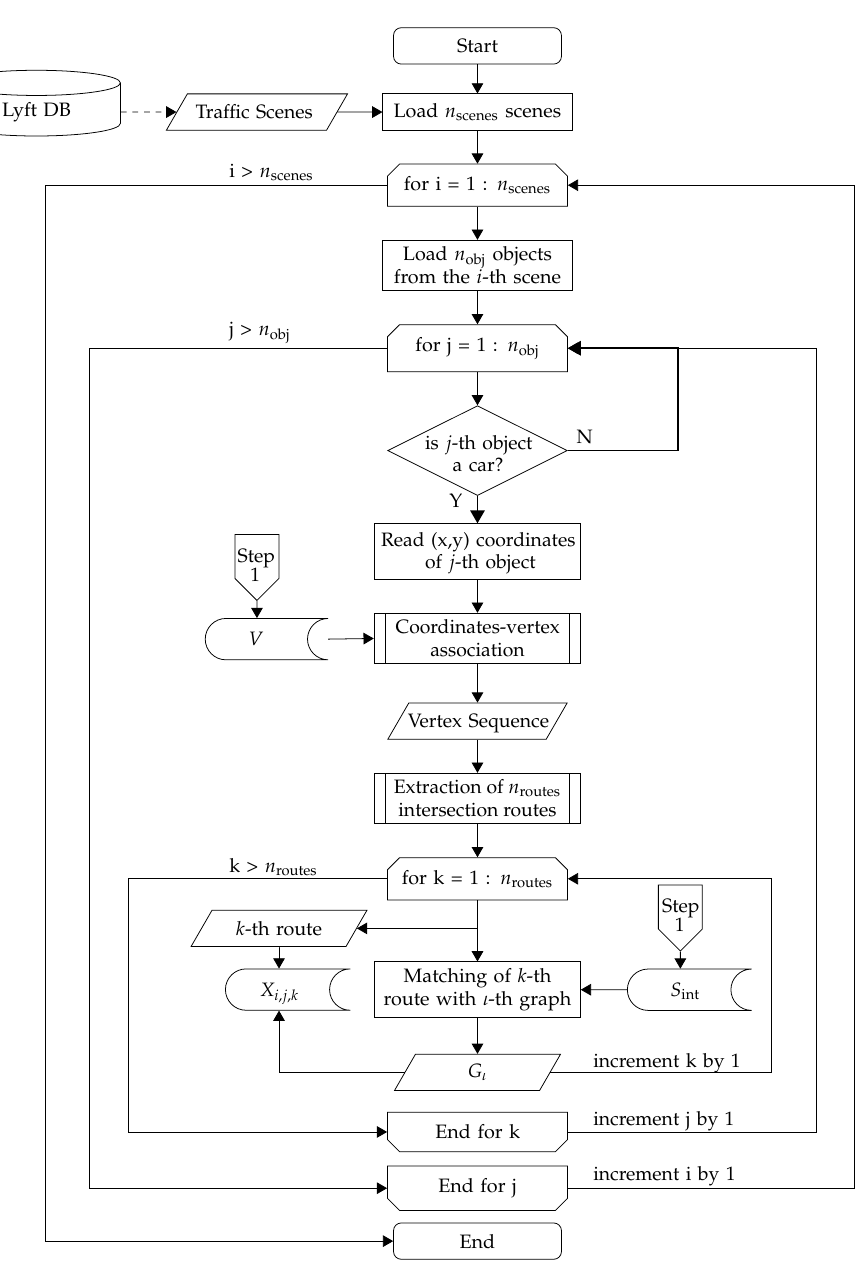
Figure 6. Shown is the process to extract the VID.